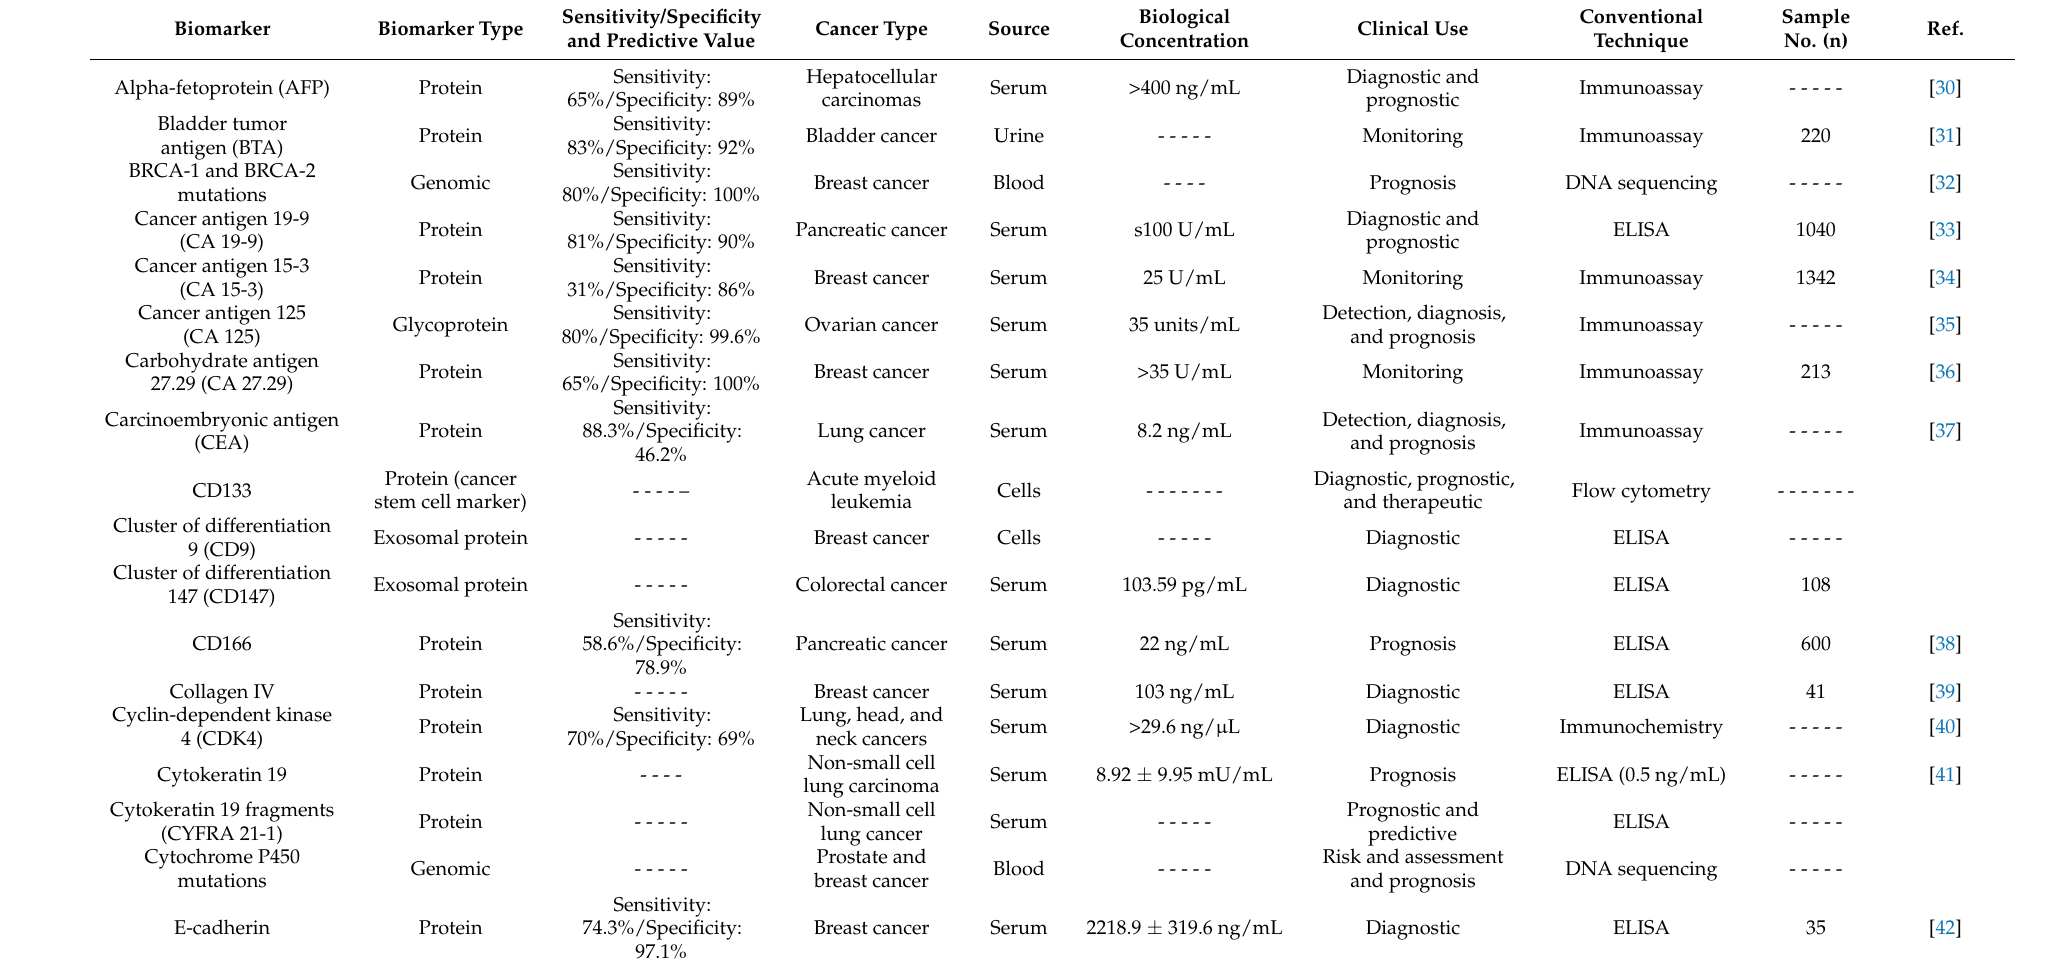
Table 1. Example of potential biomarkers for different cancer